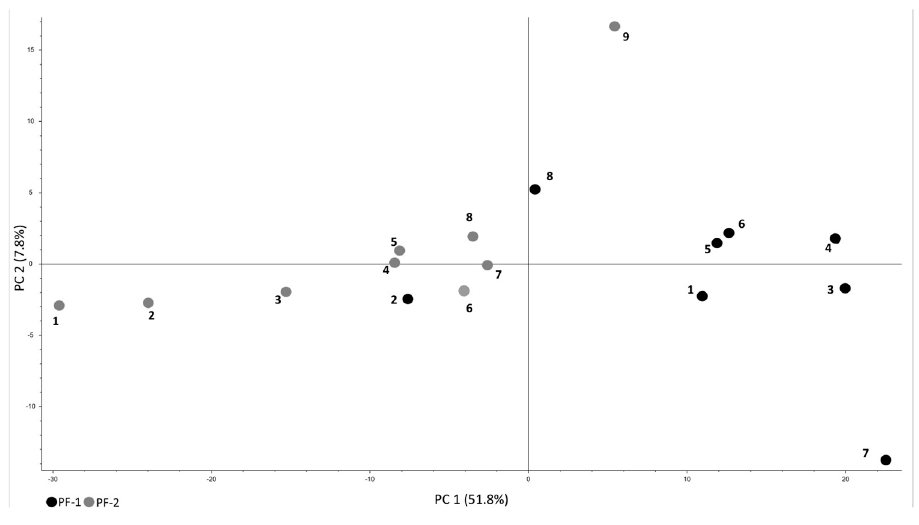
Figure 2. Principal component analysis (PCA) of observed metabolome changes among pre-frail patients at baseline (PF-1, black dots) and at the end of nutritional intervention (PF-2, grey dots).